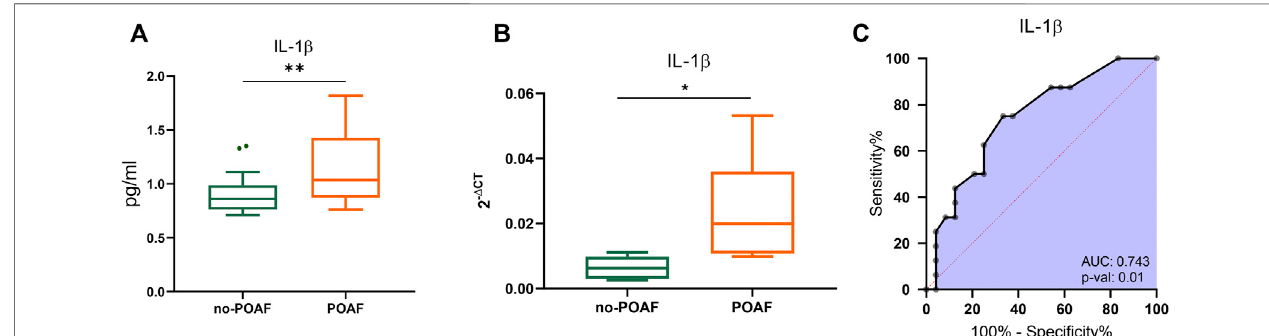
FIGURE1| IL-1 β inPOAFsubgroups. (A) BoxplotsdenoteIL-1 β concentrationdistributionsinconditionedmediafromEATbiopsiesofsubjectswiththeno-POAF outcome ( “ no-POAF ”— green) and with POAF outcome ( “ POAF ”— orange); IL-1 β concentration is expressed as pg/ml. Box plots denote median and 25th – 75th percentiles(boxes)andtukeywhiskers. (B) BoxplotsdenoteIL-1 β absoluteexpressioninEATbiopsiesfor6subjectswithnoPOAFoutcome( “ no-POAF ”— green)and6 withPOAFoutcome( “ POAF ”— orange).Boxplotsdenotemedianand25th – 75thpercentiles(boxes)andmin-to-maxwhiskers. (C) AUCofROCanalysisindicates the performance of IL-1 β . p -value refers to the signi fi cant difference from the AUC basal level of 0.5 (red dotted line). * p < 0.05; ** p < 0.01.